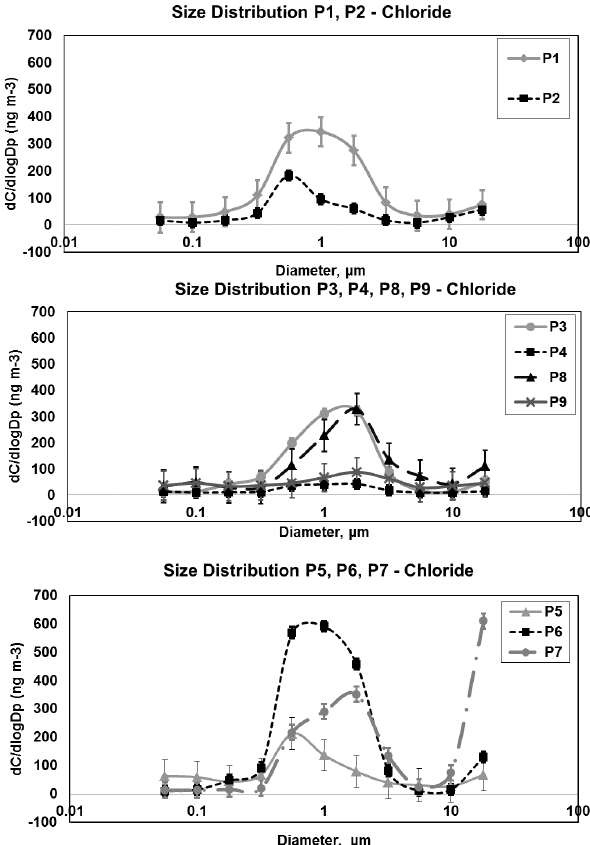
Fig. 5. Normalized size-segregated mass distribution of Cl − during the sampling periods P1–P9 listed in Table dur- 4